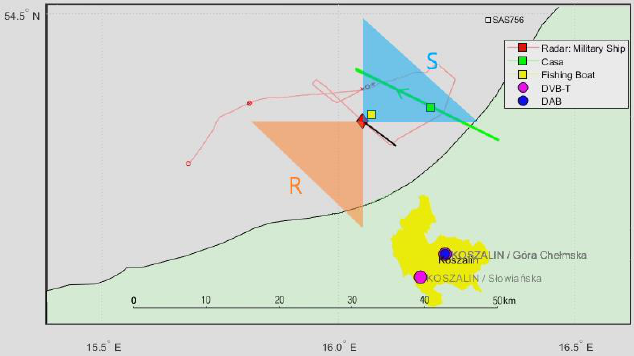
Figure 14. Situation map with a cooperative CASA C-295 aircraft and a nearby fishing boat. A signal from the DVB-T (191.5 MHz) transmitter was selected as a source of illumi- nation with receiving antennas with horizontal polarization and the reference antenna from the side of the ship. After filtering out the clutter, the echoes from the CASA aircraft can be seen as a dot moving consequently in the bistatic v / R plane (around R = 9 km), marked with red rectangles in Figure 15 (the consecutive v / R maps are separated by 4 s). The fishing boat’s echoes from the close surrounding cannot be separated from the clutter image due to the negligible Doppler frequency. The echoes from the cruise plane SAS756 that was moving more than 20 km northeast from the ship are not visible on the plots.